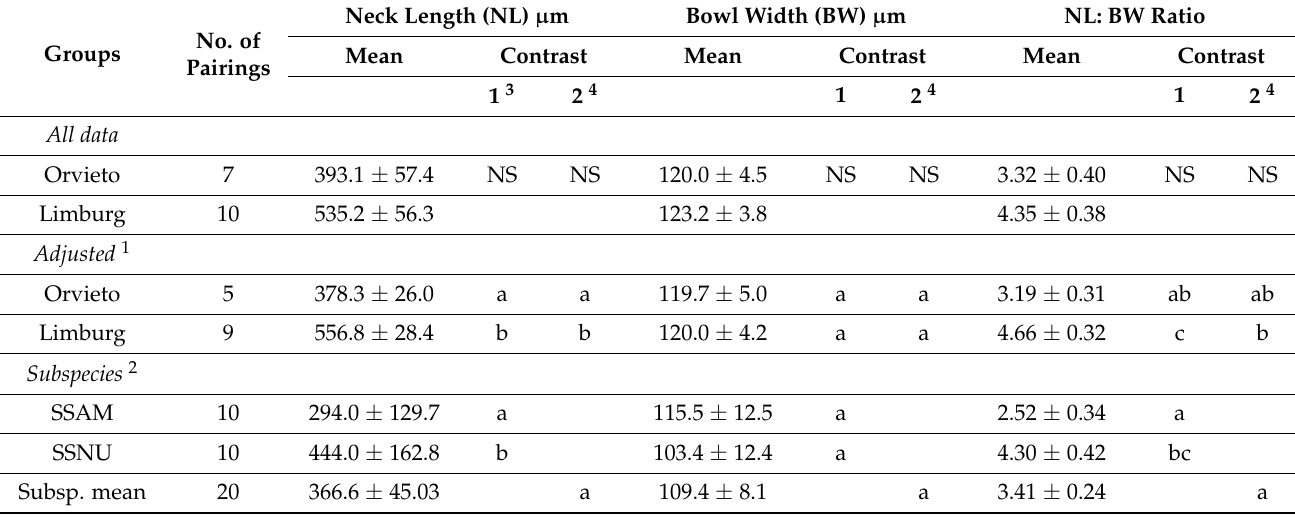
Table 4. Perithecial dimensions of within-Limburg and within-Orvieto pairings and of the parent subspecies. Groups